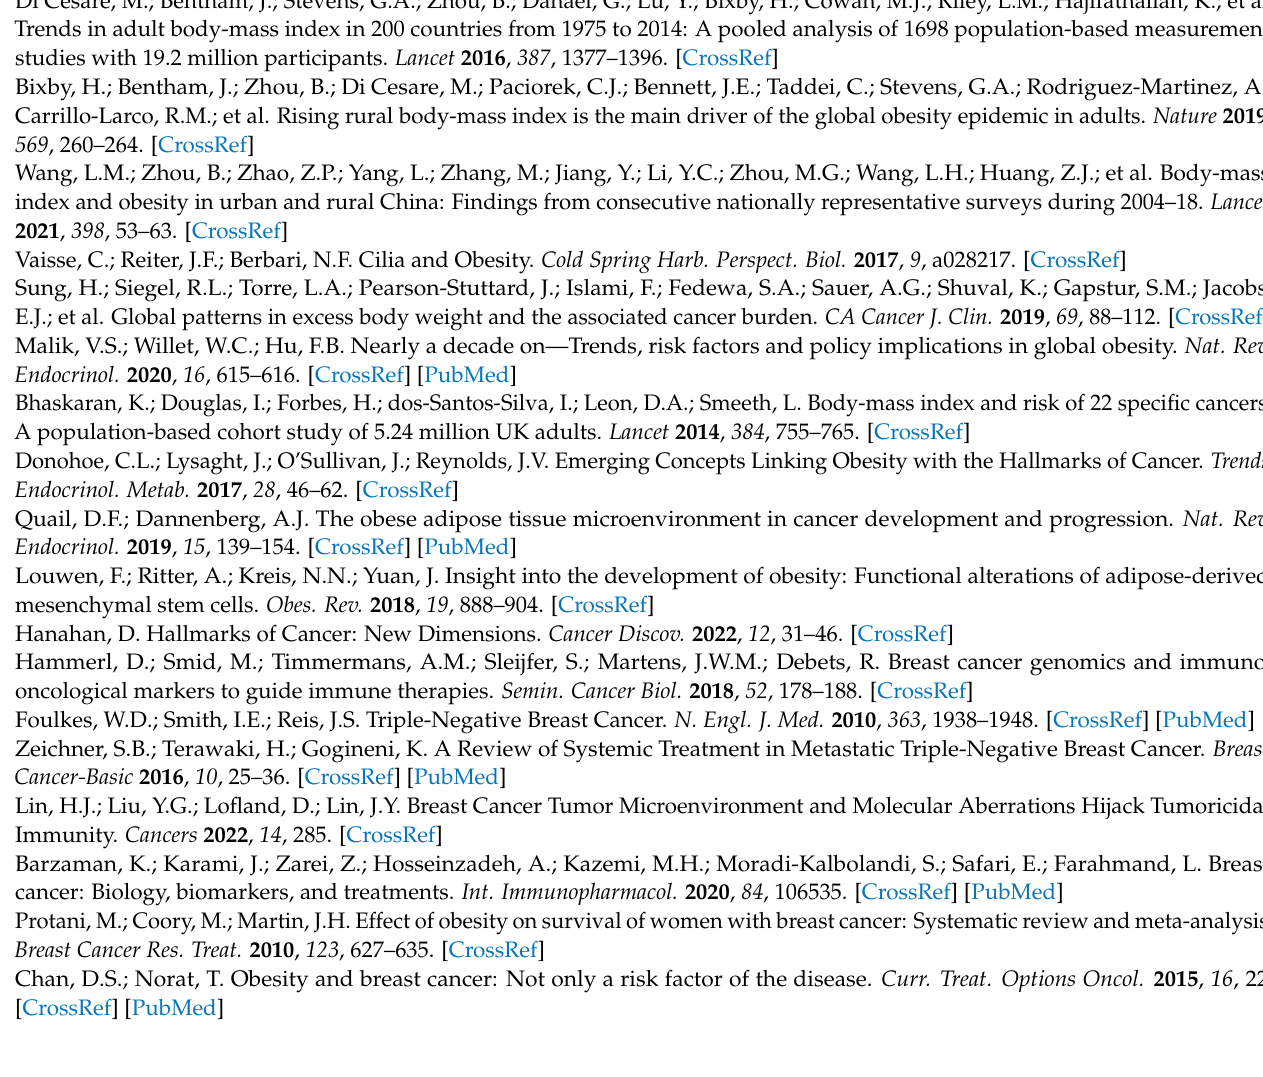
Figure preparation: A.R., J.Y. and N.-N.K. All authors have read and agreed to the published version of the